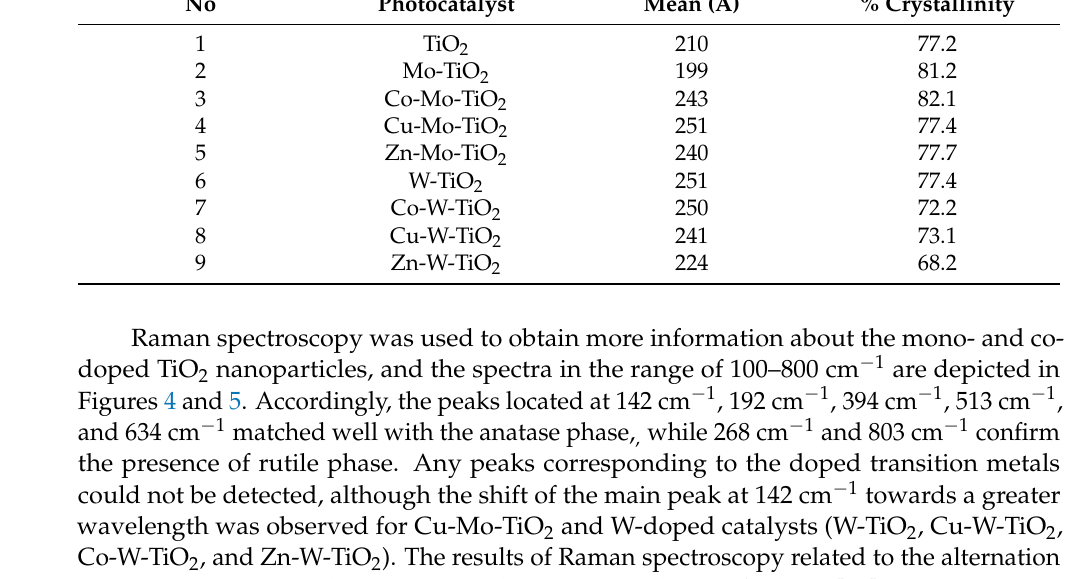
− TiO − Mo − TiO 2 , Mo 2 , Co